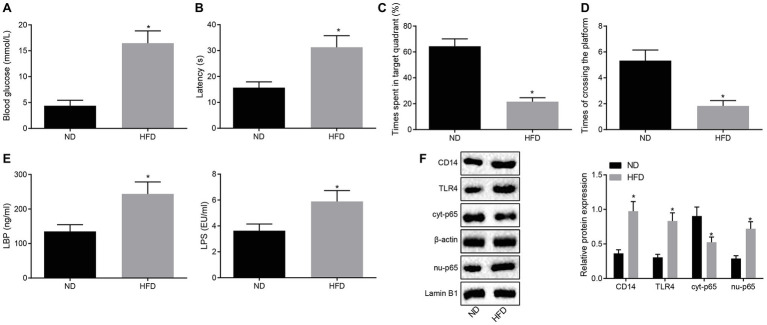
Increased lipopolysaccharide (LPS) expression and activated LPS/CD14/toll-like receptor 4 (TLR4) signaling pathway in diabetic mice. (A) Fasting blood glucose level of mice in each group. (B) The latency time of mice in each group tested by the Morris water maze experiment. (C) The time ratio of mice in each group staying on the platform quadrant tested by Morris water maze experiments. (D) The time of mice in each group crossing the target platform quadrant. (E) The levels of LPS and LBP in the plasma of mice from each group. (F) Serum levels of CD14, TLR4, and NF-κB p65 expression in hippocampal tissues of mice in each group. *p < 0.05 vs. the mice fed with normal diet (ND). The results were measurement data and expressed as mean ± standard deviation. Data between two groups were compared by independent sample t-test.